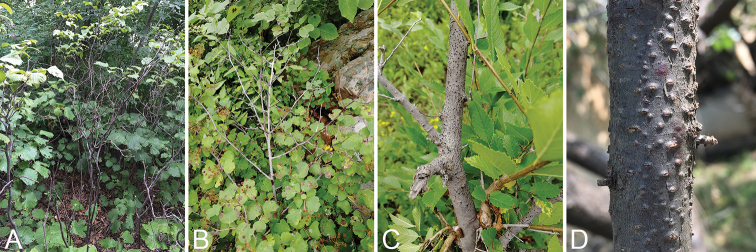
Disease symptoms associated with Cytospora species. ACorylus
mandshuricaBSpiraea
salicifoliaCUlmus
pumilaDPrunus
sibirica.